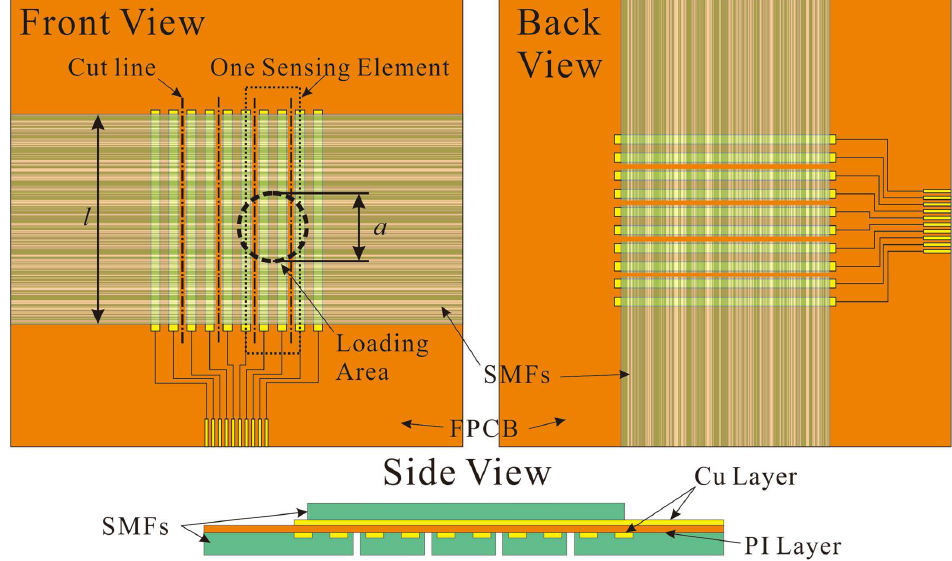
Figure 2. The schematic demonstration of the proposed flexible tactile sensor with two orthogonal unidirectional composite sub-microfiber (SMFs) layers on both side of flexible printed circuit board (FPCB). One SE consisting of parallel SMFs between two electrodes is indented with a round contact area as in the